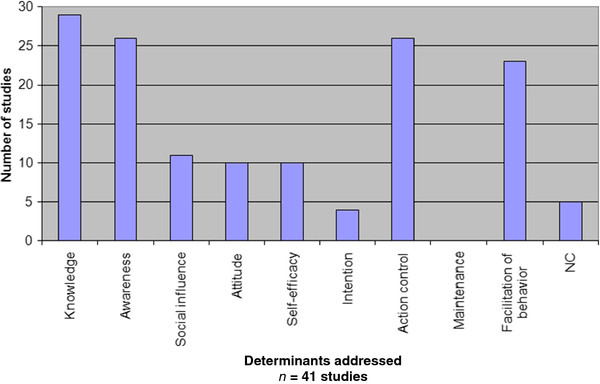
Numbers of studies addressing specific determinants of behaviour change. Knowledge (29), Awareness (26), Social influence (11), Attitude (10), Self-efficacy (10), Intention (4), Action Control (26), Maintenance (0), Facilitation of behaviour (23), NC = no coding possible (5). Total = 144 in 41 studies.